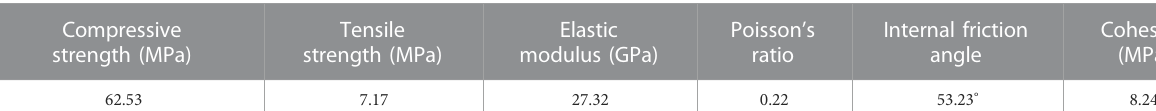
TABLE 2 Rock mechanical parameters at the M8Z2-TAW-41 exploration hole.